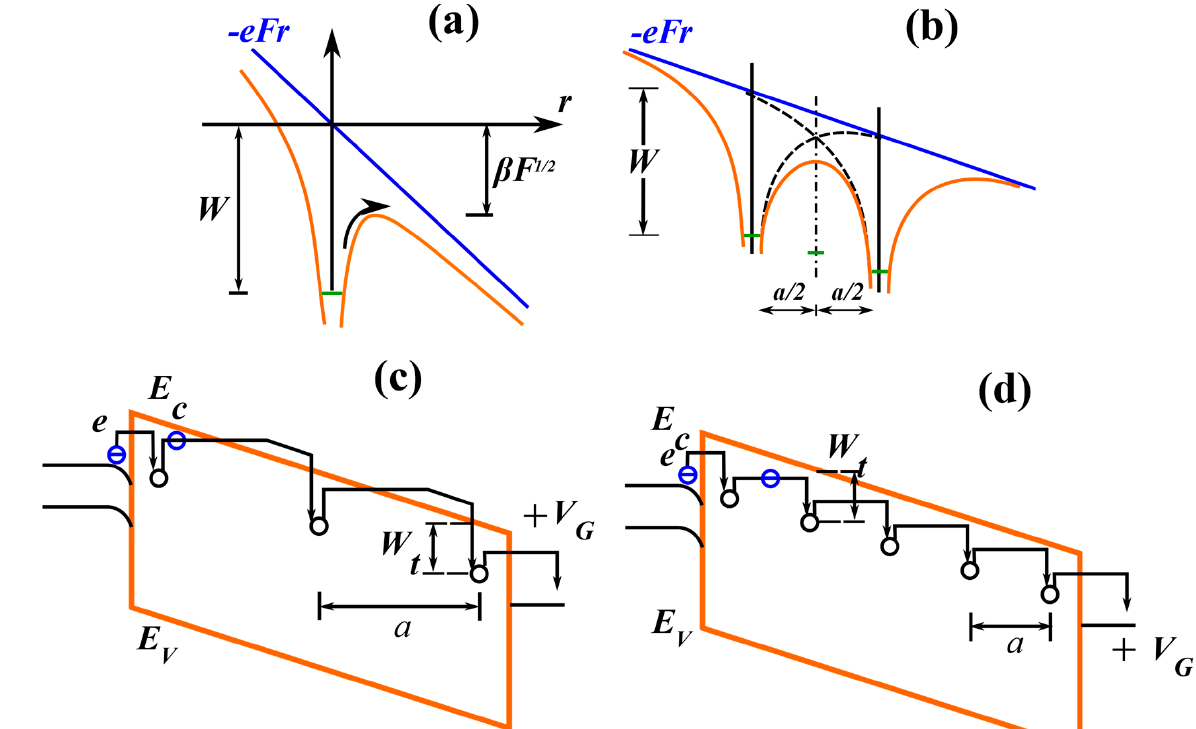
Figure 2. Schematic diagram of bulk-limited models: ( a ) Frenkel effect, ( b ) Hill–Adachi model of overlapping Coulomb potentials, ( c ) Makram–Ebeid and Lannoo multiphonon isolated trap ionization model, ( d ) Nasyrov–Gritsenko phonon-assisted tunneling via neighboring traps